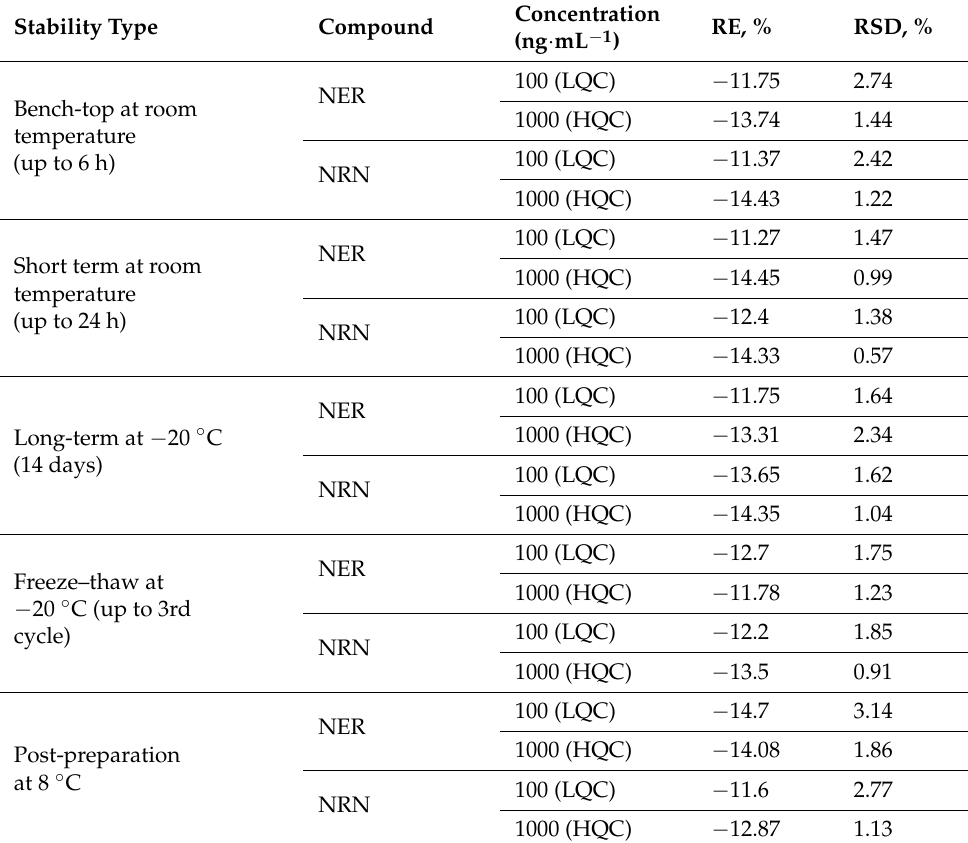
Table 3. Stability data of the